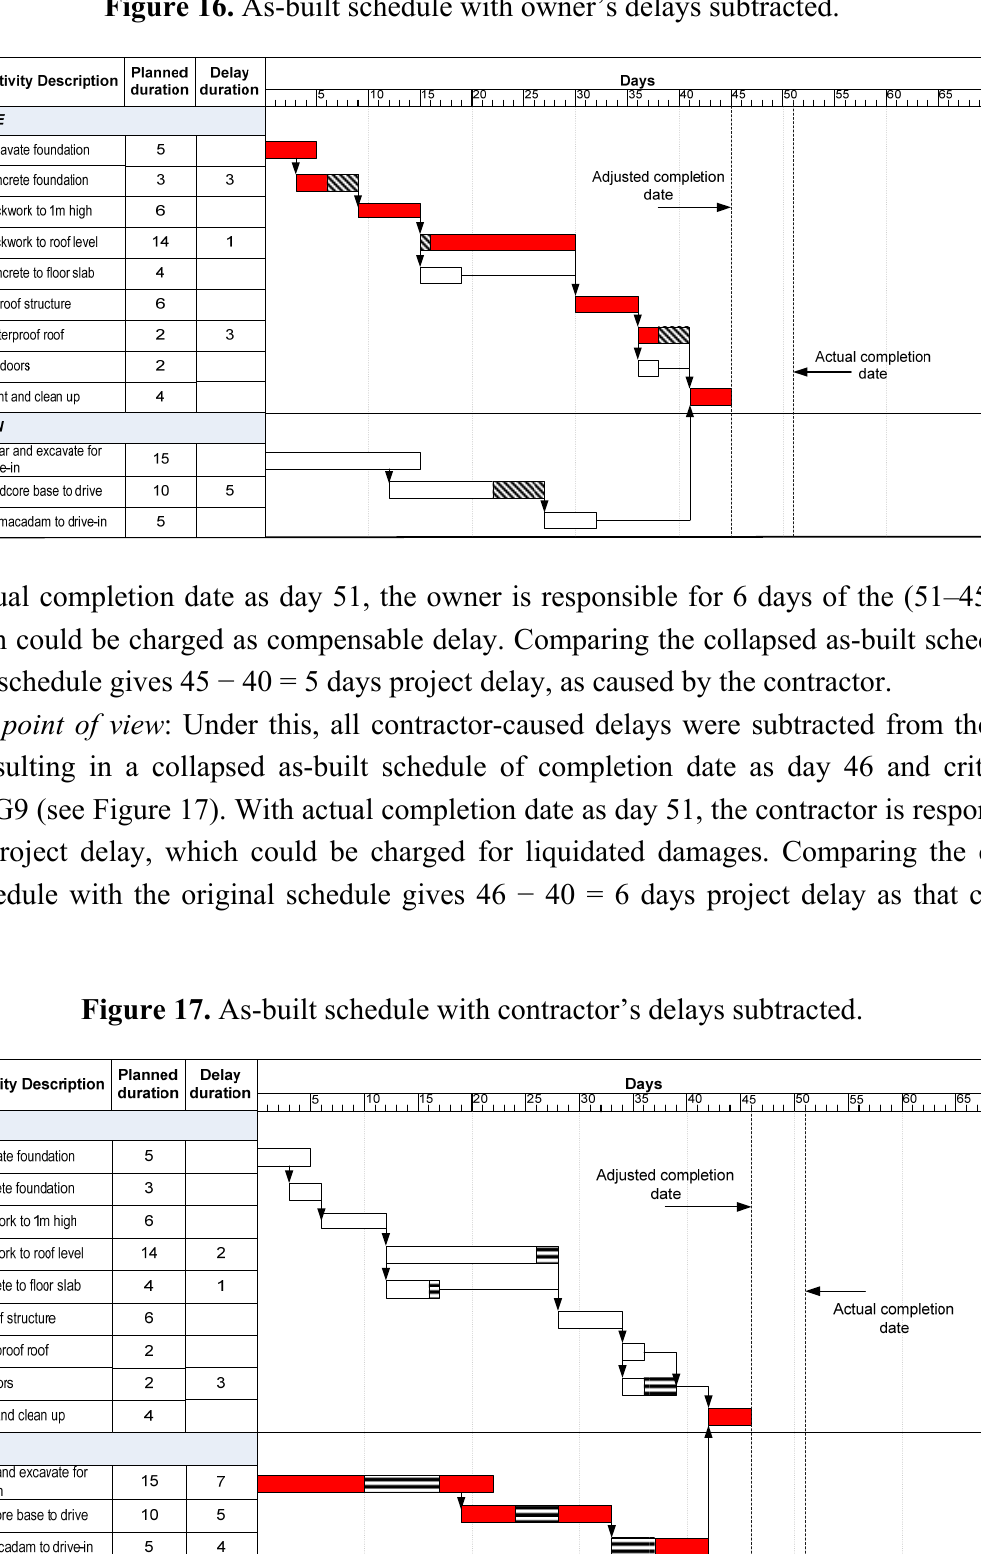
Figure 16. As-built schedule with owner’s delays subtracted.